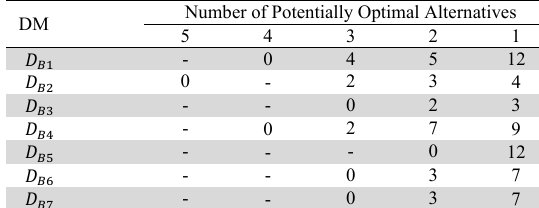
FITradeoff current results for case A.